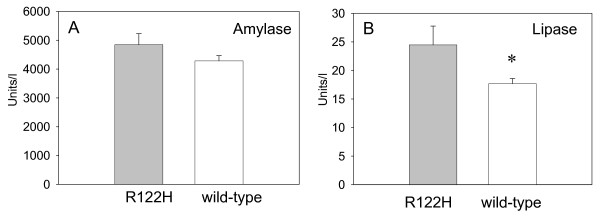
Basal serum levels of amylase and lipase in R122H-trypsinogen transgenic mice and controls: Serum levels of amylase (a) and lipase (b) were measured in a minimum of 10 animals per group (R122H transgenic mice: grey, wild-type mice: white). Statistical analysis using the Mann-Whitney-Test with p < 0.05 was considered significant.